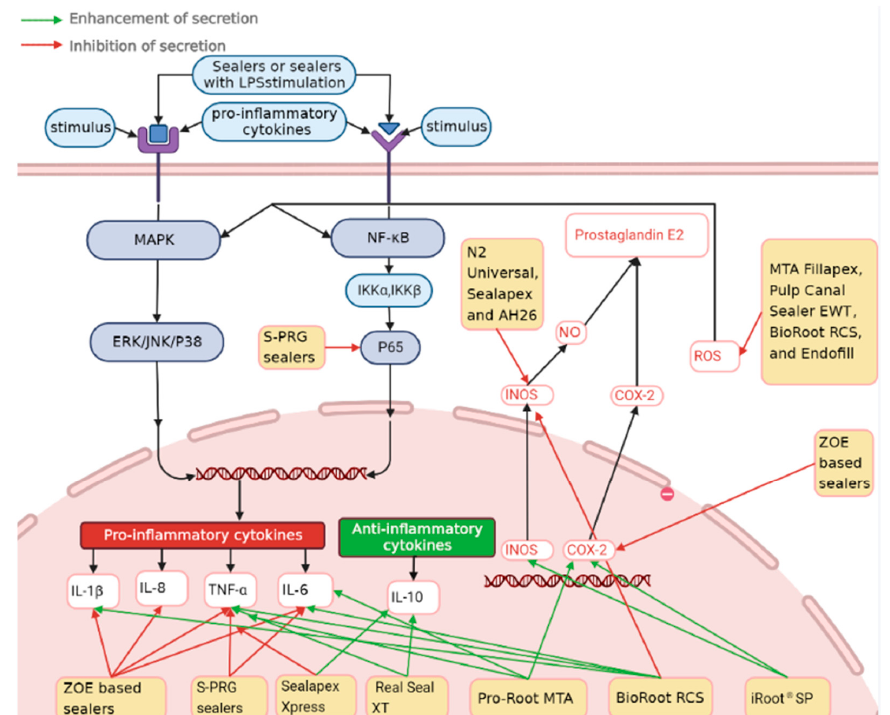
Figure 3. Immunomodulatory effects of endodontic sealers on cytokine production and potential pathways (Pro-Root MTA is an endodontic cement). Arrows in red and green represent the inhibition and enhancement effects of cytokines or signal molecules production on endodontic sealers in macrophages and monocytes.